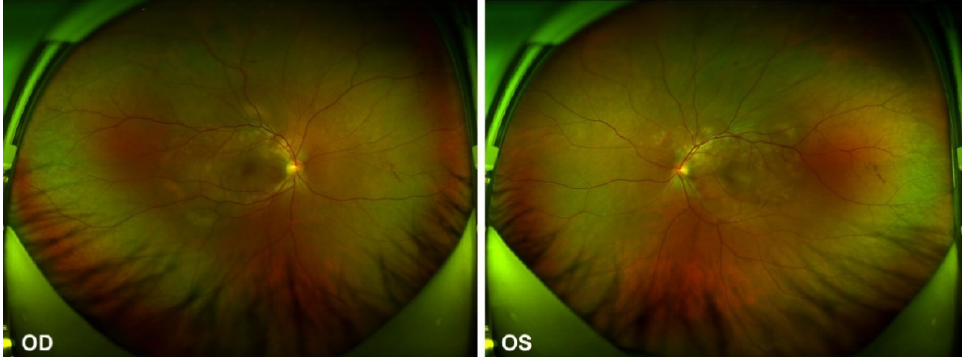
Figure 1. Ultra-widefield Scanning Laser Ophthalmoscope (SLO) retinal imaging during the first Figure 1. Ultra ‐ widefield Scanning Laser Ophthalmoscope ( SLO) retinal imaging during the first evaluation: multifocal serous retinal detachment OU. evaluation: multifocal serous retinal detachment